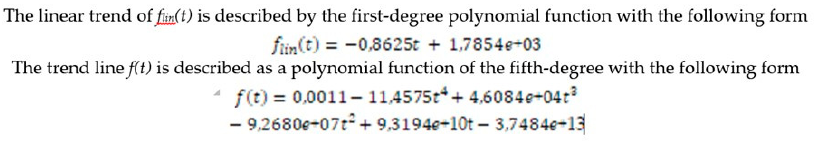
Figure 9. Trends of changes in the seriousness of workplace accidents in civil engineering over time.